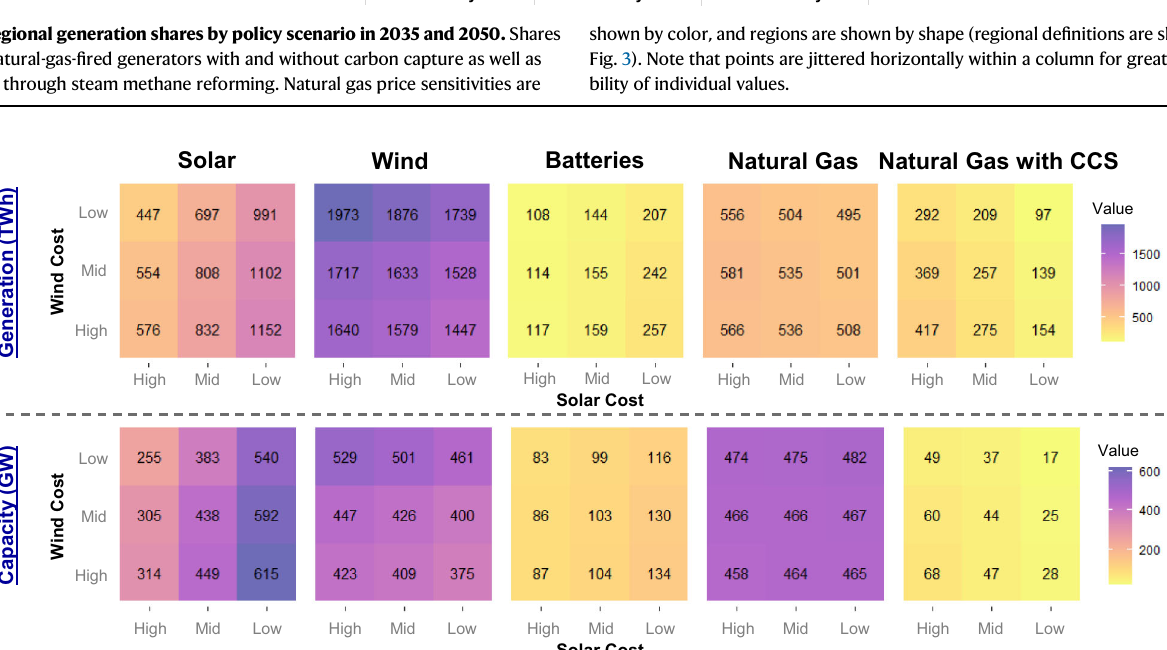
Fig.5|Generationandcapacitybytechnology(columns)acrosswind/solarcostscenarios(panels)in2035. ResultsareshownfortheNet-Zeroin2035scenario.Low, Mid, and High renewable cost assumptions are shown in Supplementary Fig. 5. CCS carbon capture and sequestration.